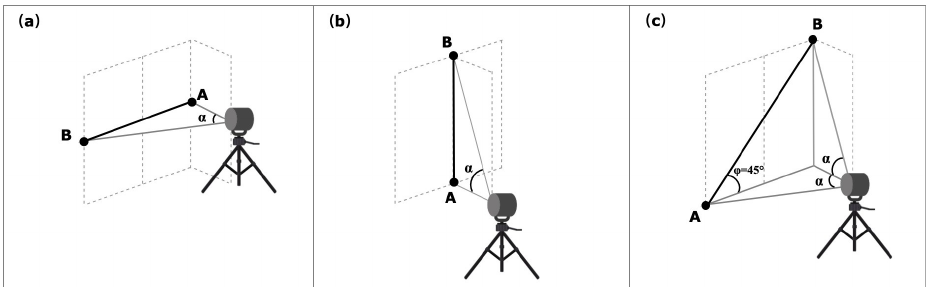
Figure 9. The layout of asymmetric tests for the sphere targets A and B placed in orientations ( a – c ). α is an angular sweep between two targets, and ϕ is the angle between the bar and plane, source: adapted with permission from [22].